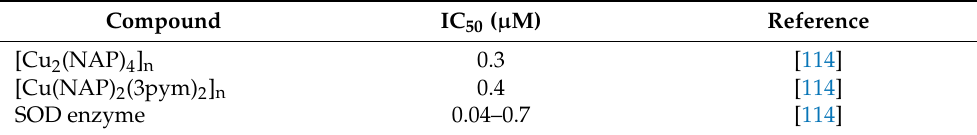
Table 11. SOD-like activity (IC 50 , in µ M) of reported Cu(II)–naproxen